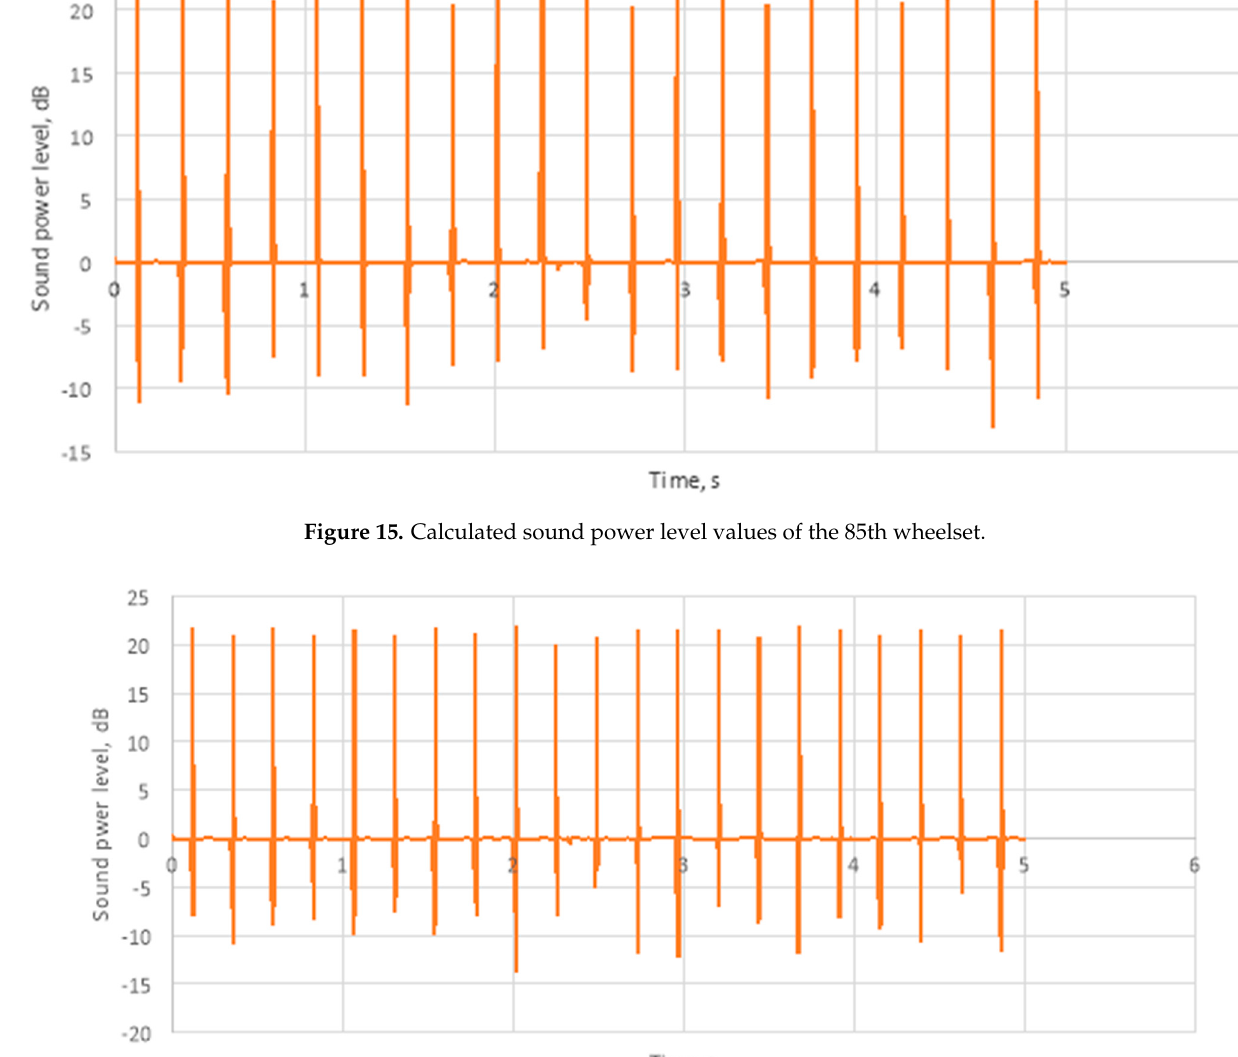
Figure 16. Calculated sound power level values of the 87th wheelset. Comparison of the results of the physical and the numerical experiments shows correlations. Force correlations are shown in Figure 17.